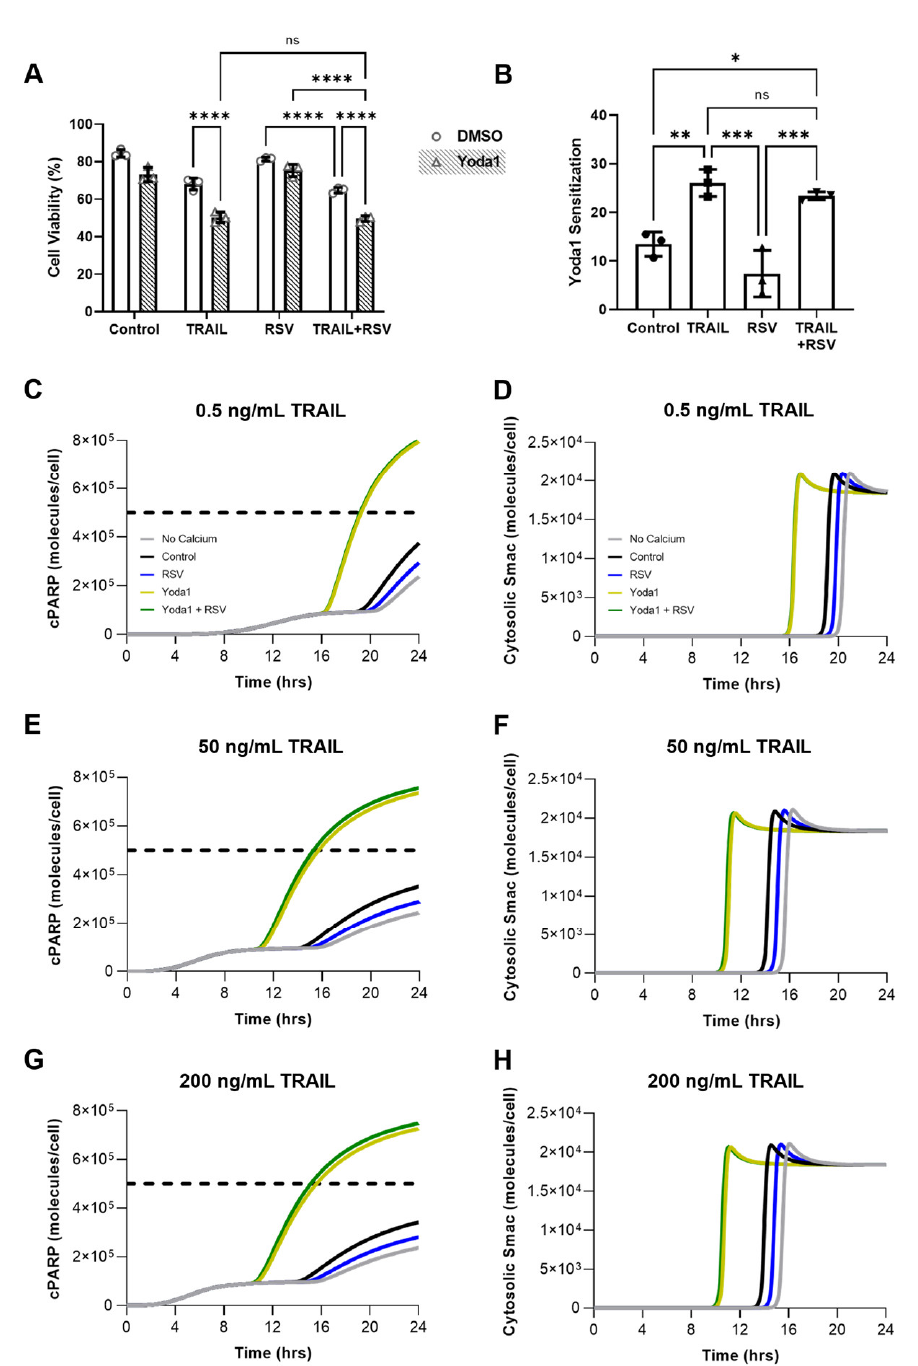
Figure 8. Resveratrol has a minimal effect on the TRAIL sensitizing ability of Yoda1. ( A ) SW480 cells treated for 24 h with 10 µ M Yoda1 and 50 ng/mL TRAIL with or without 50 µ M pretreatment with resveratrol. N = 3, **** p < 0.0001 (two-way ANOVA with multiple comparisons). Error bars represent mean ± SD. ( B ) Yoda1 sensitization from cell viabilities shown in ( A ). N = 3, ns = not significant, * p < 0.05, ** p < 0.01, *** p < 0.001 (one-way ANOVA with multiple comparisons). Error bars represent mean ± SD. ( C – H ) Computational model of apoptosis for 0.5 ng/mL, 50 ng/mL and 200 ng/mL TRAIL measuring concentrations of cleaved PARP and cytosolic Smac over time. In vitro calcium concentrations were used and normalized to Yoda1 (1 µ M). Cells were considered apoptotic at cPARP concentrations exceeding 5 × 10 5 molecules/cell.